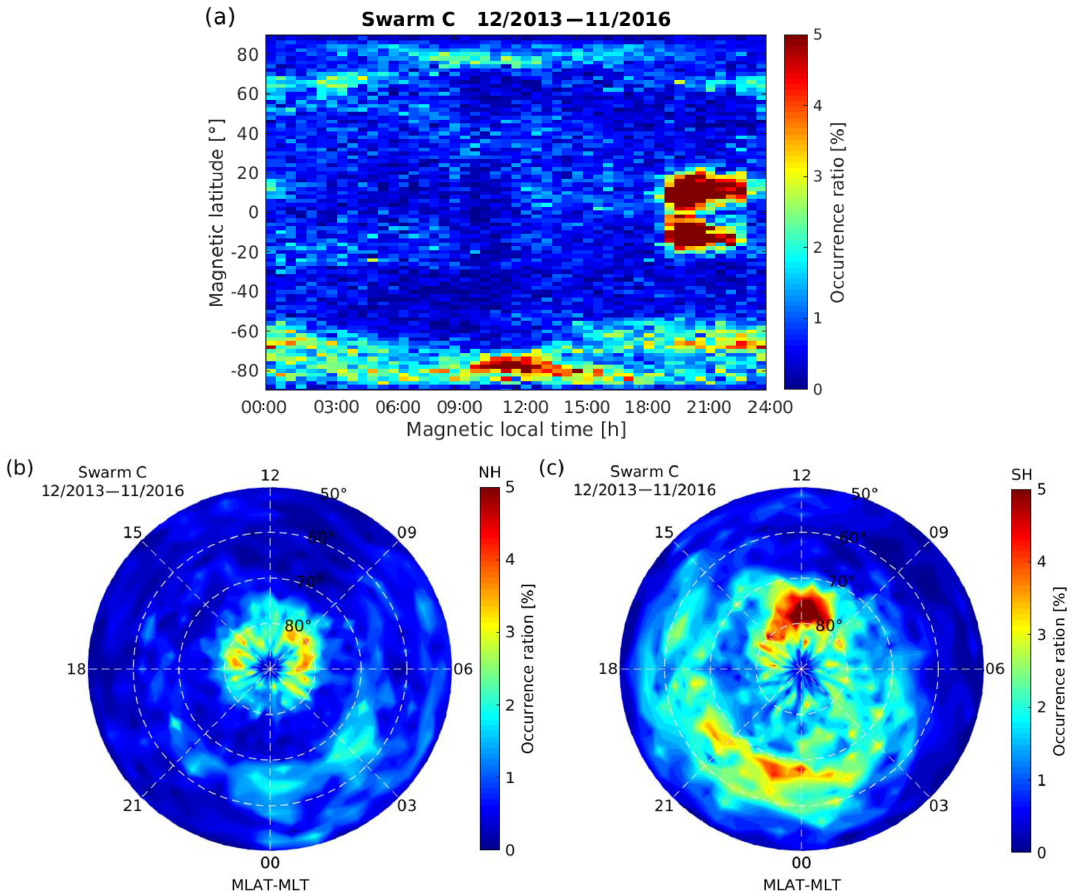
Figure 3. (a) The MLAT vs. MLT distribution of GPS signal loss observed by Swarm C. (b) Similar to (a) but only for northern high latitudes (MLAT > 50 ◦ ) in the polar view. (c) Similar to (a) but for the southern high latitudes (MLAT < − 50 ◦